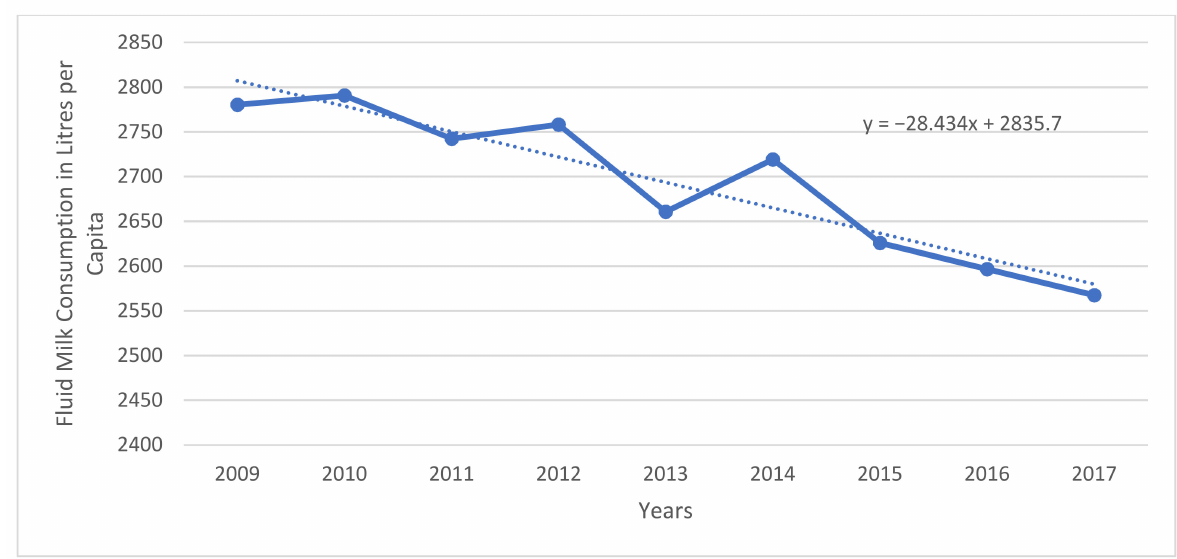
Figure 2. Global Fluid Milk Consumption in Liters per Capita (2009 to 2017 for Countries in which Data for all Years is Available). Source: Statistics Canada; Compiled by Agriculture and Agri-Food Canada, Animal Industry Division, Market Information Section.